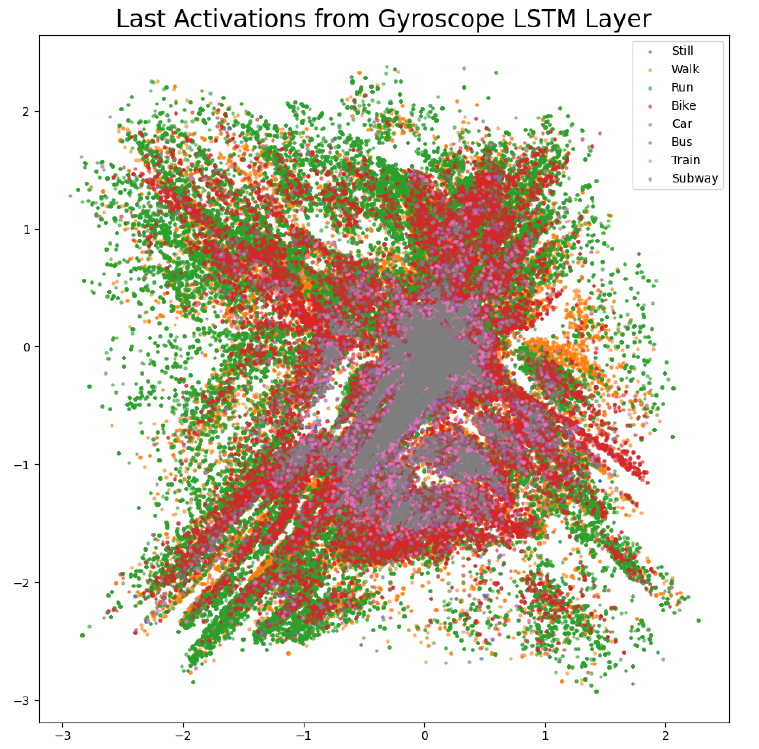
Figure 11. The 2D encoded representation of the last activations of the LSTM layer for the gyroscope. Color codes: blue (still), orange (walk), green (run), red (bike), violet (car), brown, (bus), pink (train), grey